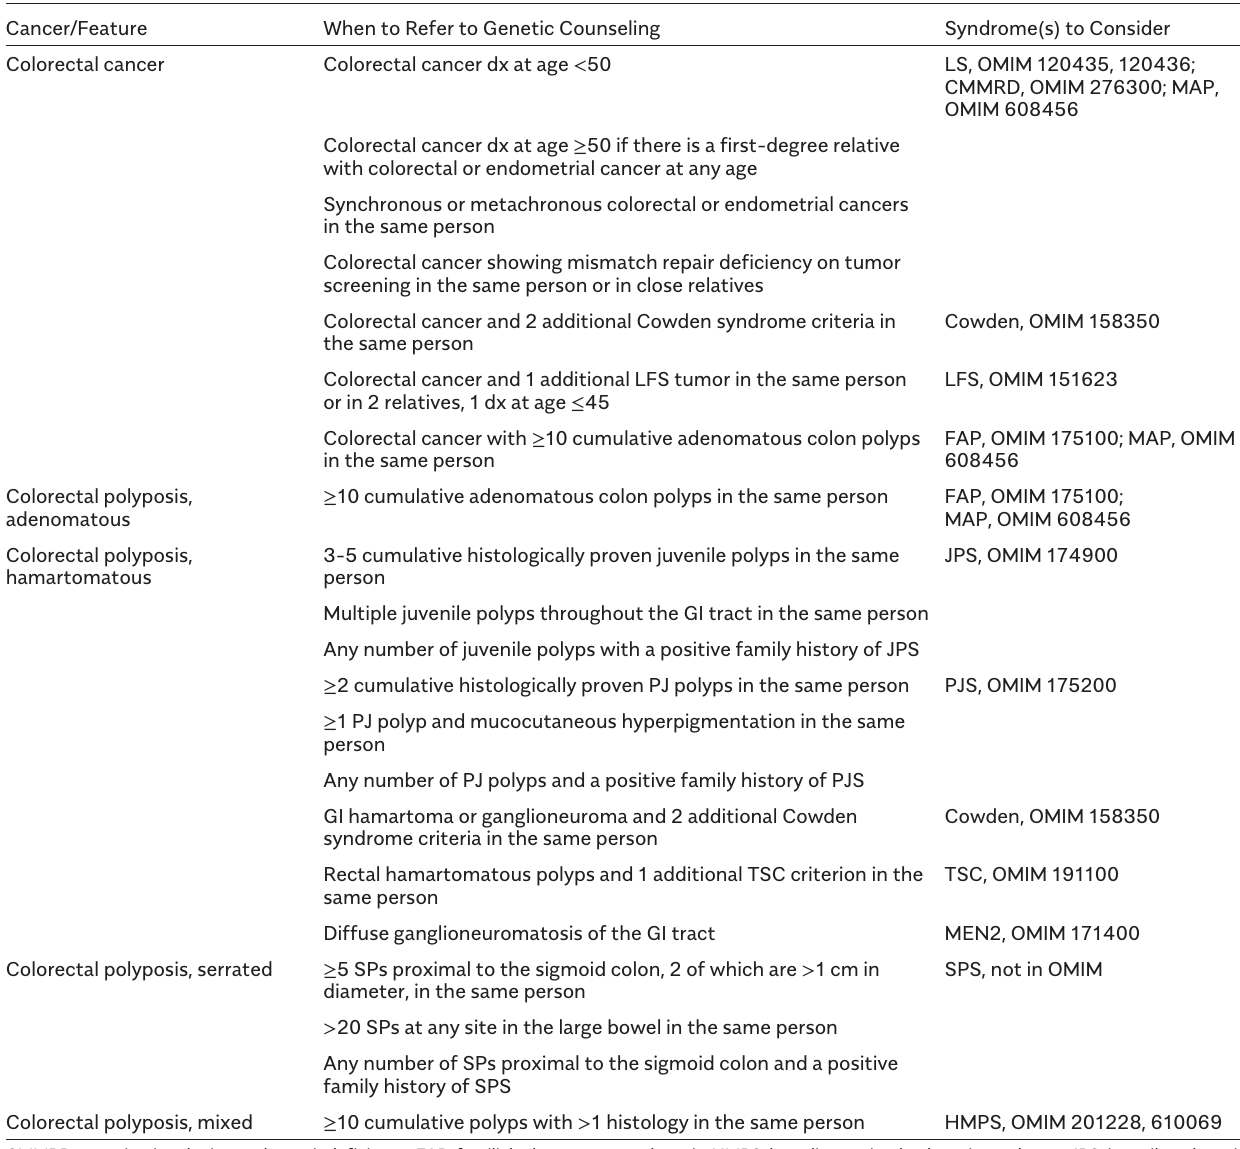
Table 3. Criteria that Warrant Assessment for CRC Syndromes Predisposition Cancer/Feature When to Refer to Genetic Counseling Syndrome(s) to Consider Colorectal cancer Colorectal cancer dx at age < 50